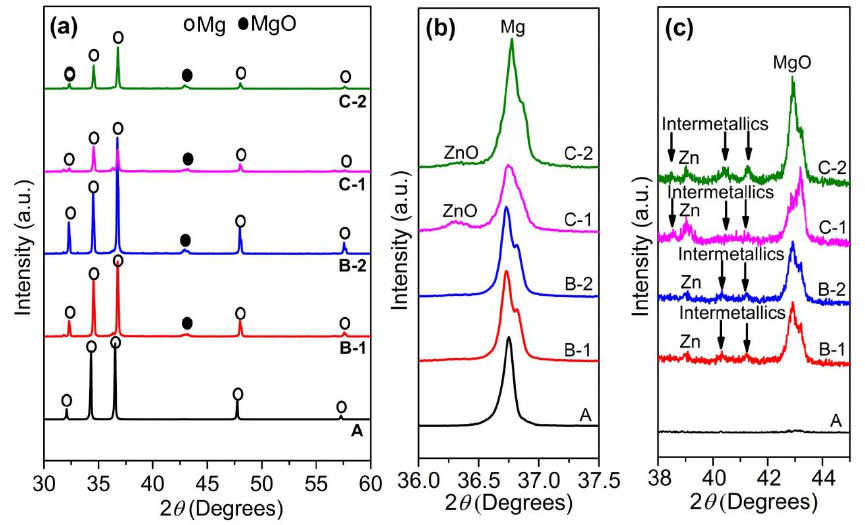
Figure 1. XRD (X-ray diffractometry) patterns of as fabricated samples, ( a ): full scan range of 2θ from 30 to 60 degrees; ( b ): magnification of 2θ from 36 to 37.5 degrees; and ( c ): magnification of 2θ from 38 to 45 degrees.